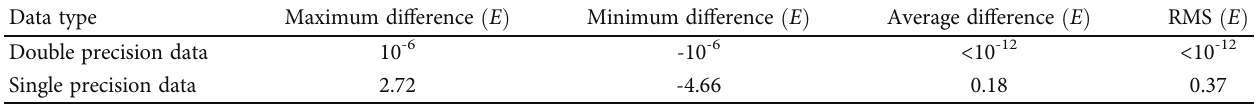
Table 8: Numerical characteristics of T